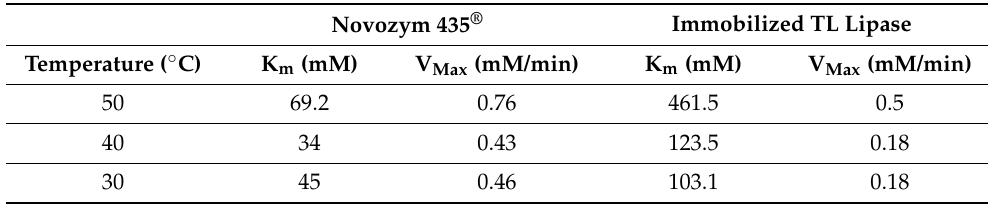
Table 4. Kinetic parameters of immobilized TL lipase and the Novozym 435 ® biocatalyst in esterifica- tion to obtain